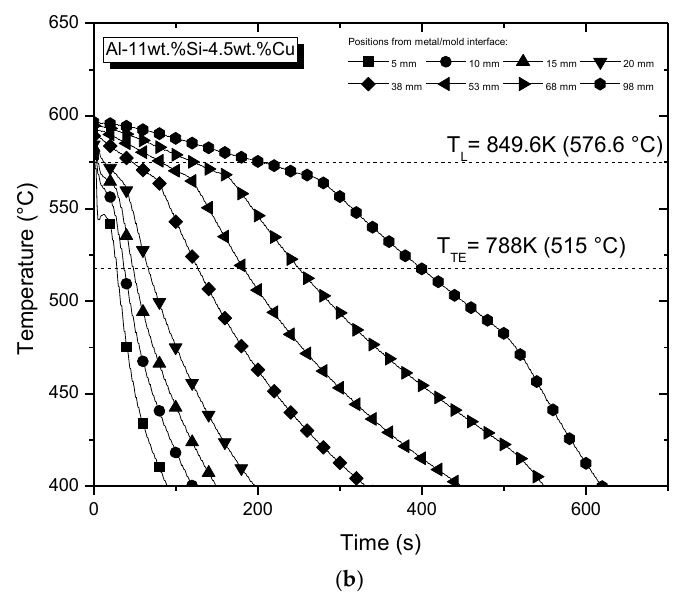
Figure 3. Experimental cooling curves considering different positions along the length of the ( a ) Al-11wt. %Si-3.0wt. %Cu and ( b ) Al-11wt. %Si-4.5wt. %Cu alloy castings. Each mentioned position refers to a thermocouple inserted within the DS casting.